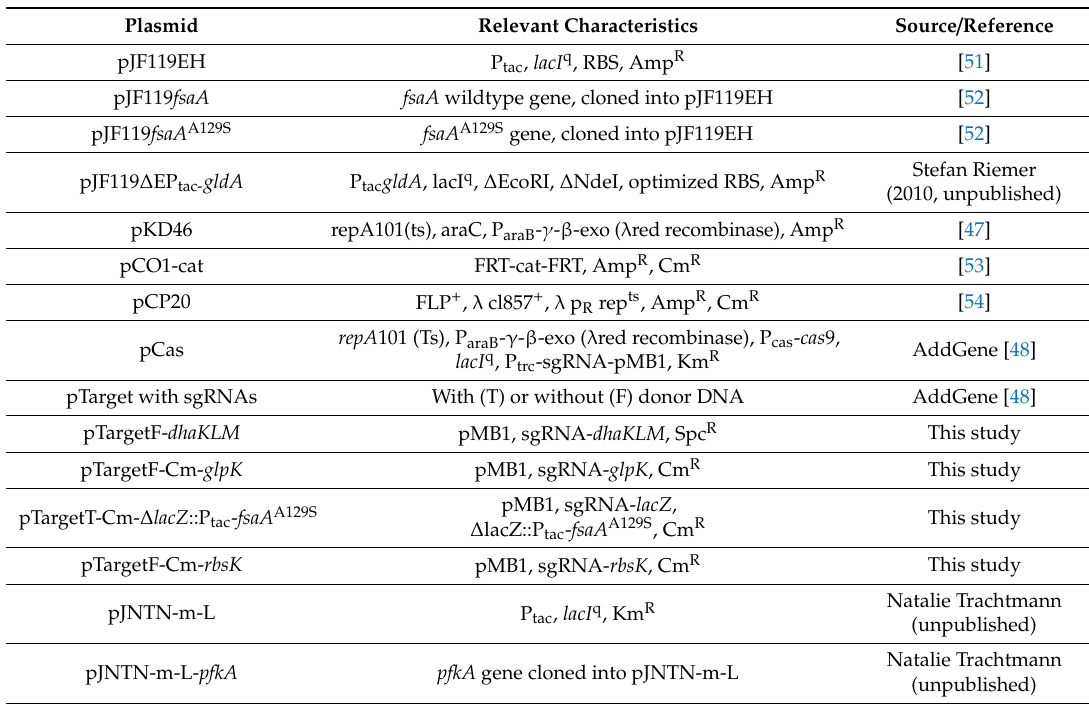
Table 3. Plasmids used during this study. RBS, ribosome binding site; ts, temperature-sensitive replication. Amp R , ampicillin resistance gene; Cm R , chloramphenicol resistance gene; Km R , kanamycin resistance gene; Spc R , spectinomycin resistance